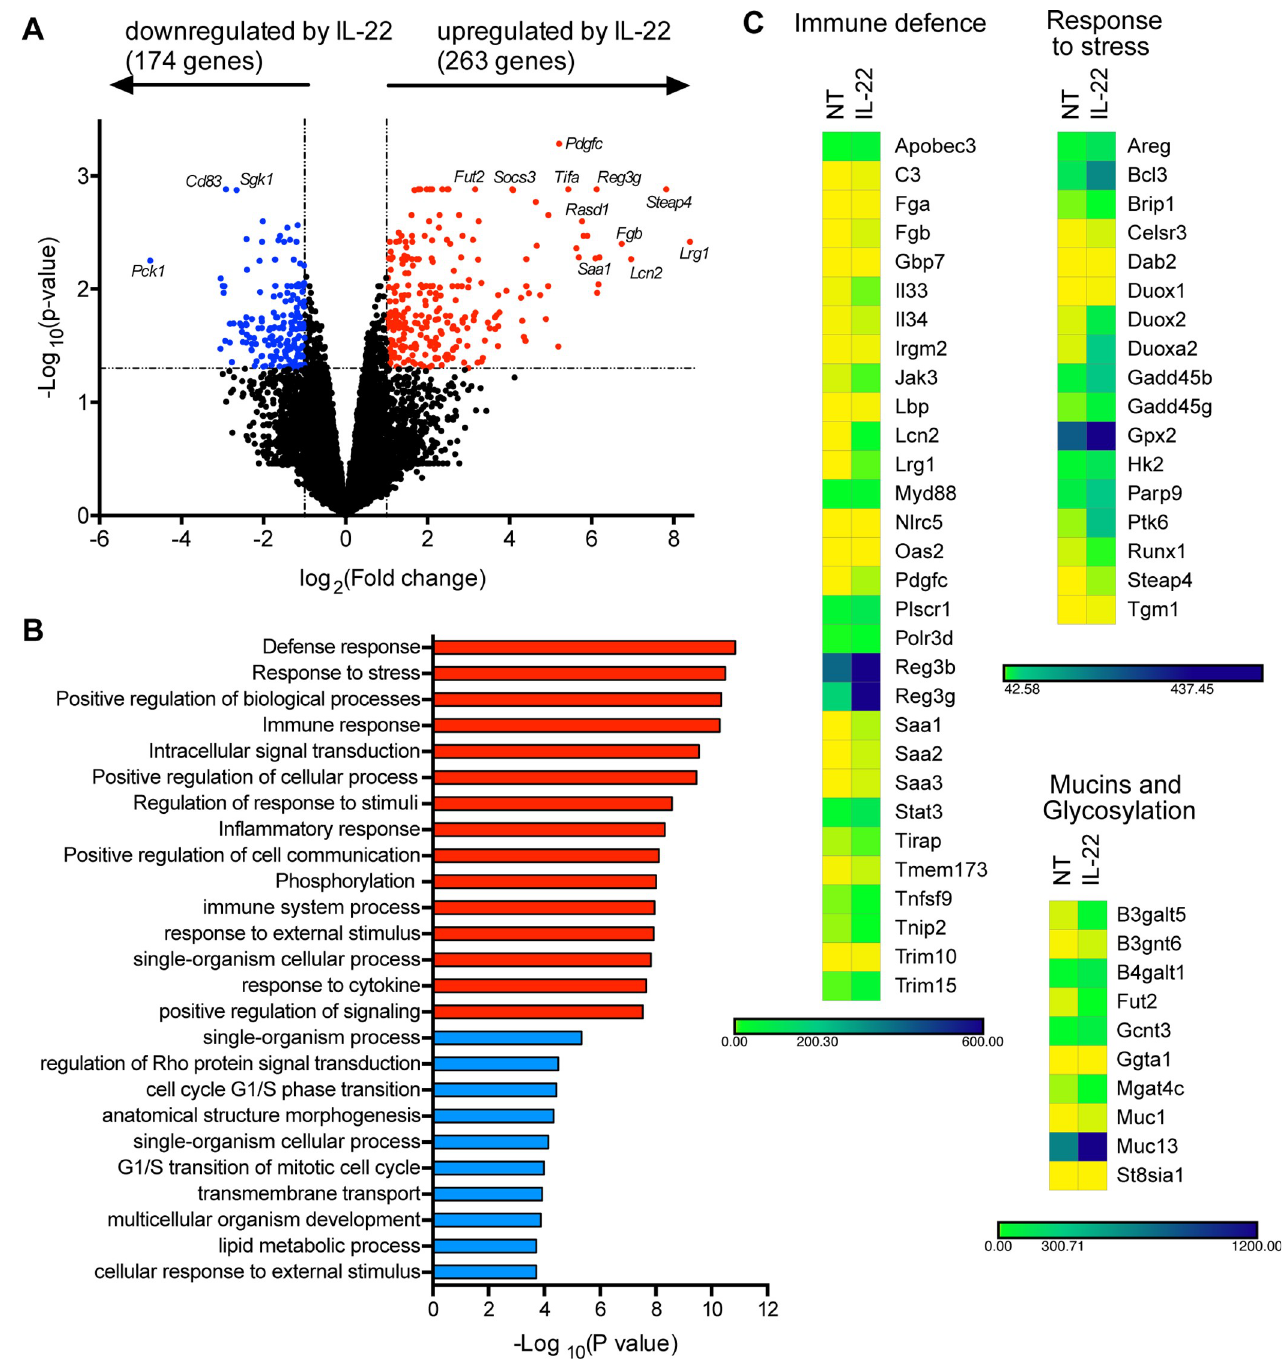
Fig 1. IL-22 regulates genes involved in intestinal immune defence responses. WT organoids were treated with IL-22 (2 ng/ml) for 3 hours. RNA was isolated for RNAseq analysis. (A) Volcano plot showing fold change (log 2 ) in gene expression of WT organoids treated with IL-22 (2 ng/ml) for 3 hours compared to untreated WT organoids, plotted against significance ( − log 10 [ p -value]). Red = significantly up-regulated gene (fold change > 2, p < 0.05), blue = significantly down-regulated genes (fold change < 0.5, p < 0.05). (B) Functional enrichment analysis (GO term: “Biological processes”) for genes up- or down-regulated in WT organoids treated with IL-22, compared to untreated WT organoids. Shown are the top 15 up-regulated (red) and 10 down-regulated pathways (blue). (C) Heatmaps displaying mRNA expression level of significantly regulated genes in WT organoids either not treated or treated with IL-22. Genes of interest were manually grouped by their main biological function. Numerical values for panel B are available in S1 Data and for panels A and C in S2 Table. GO, gene ontology; IL-22, interleukin-22; NT, not treated; RNAseq, RNA sequencing; WT, wild-type.